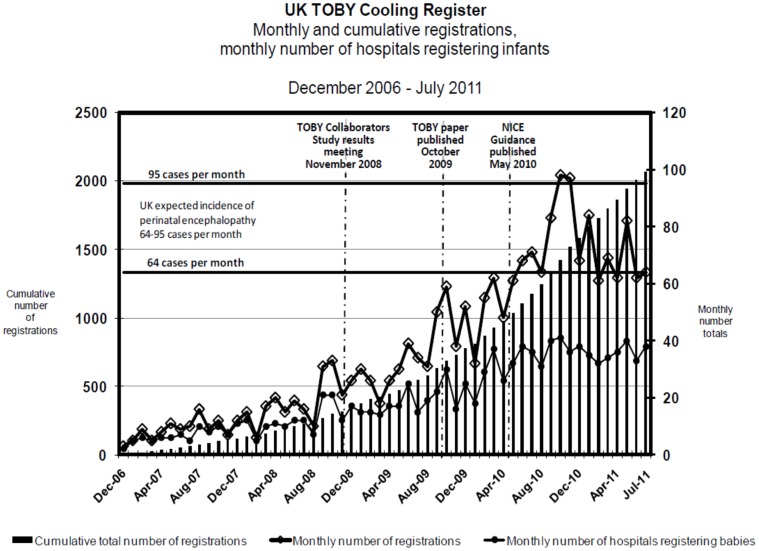
UK TOBY Cooling Register: number of registrations and cooling centres by month.The horizontal lines indicate the range of expected eligible cases in the UK.